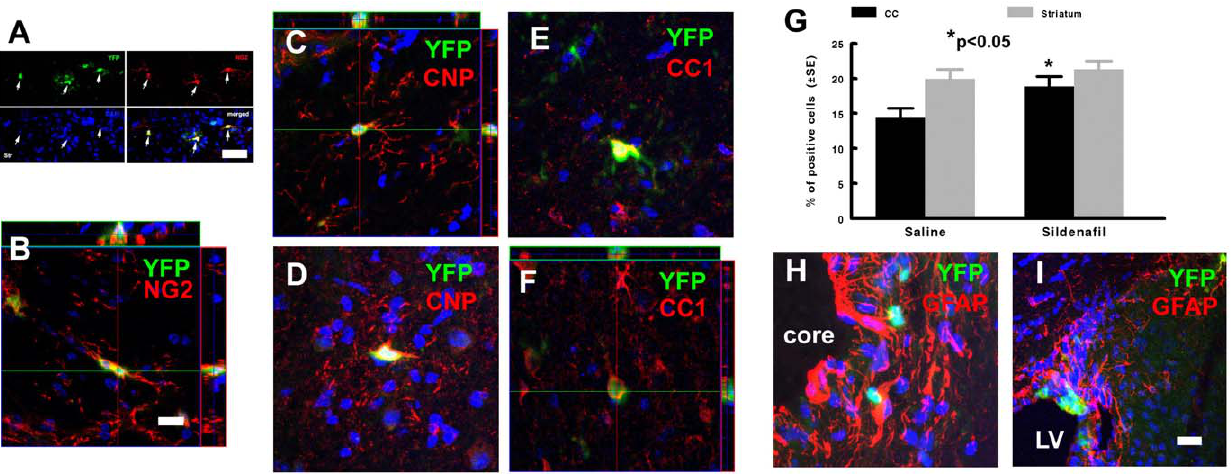
Figure 3. Representative confocal microscopic images (A to F, H, I) show that YFP immunoreactive cells (green) were NG (A, B, red), CNPase (C, D, red), CC1 (E, F, red), and GFAP (H, I, red) positive in the corpus callosum (A, C, E), striatum (B, D, F, H) and SVZ (I) of the ischemic hemisphere in middle-aged mice 30 days after stroke. Panel G shows percentage of YFP/CNPase positive cells in the ipsilateral corpus callosum and striatum in middle-aged mice treated with saline and Sildenafil. *p , 0.05 vs saline group. n=10/saline and n=11/Sildenafil. Bars =10 m m. Blue color = cell nuclei. CC = corpus callosum, LV = lateral ventricle.